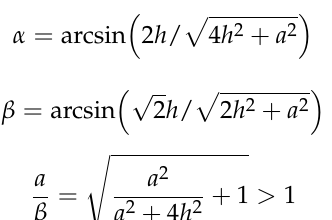
Figure 13. The relationship between stress difference ( σ = S y − S x ) and l 1 for two diaphragm structures.